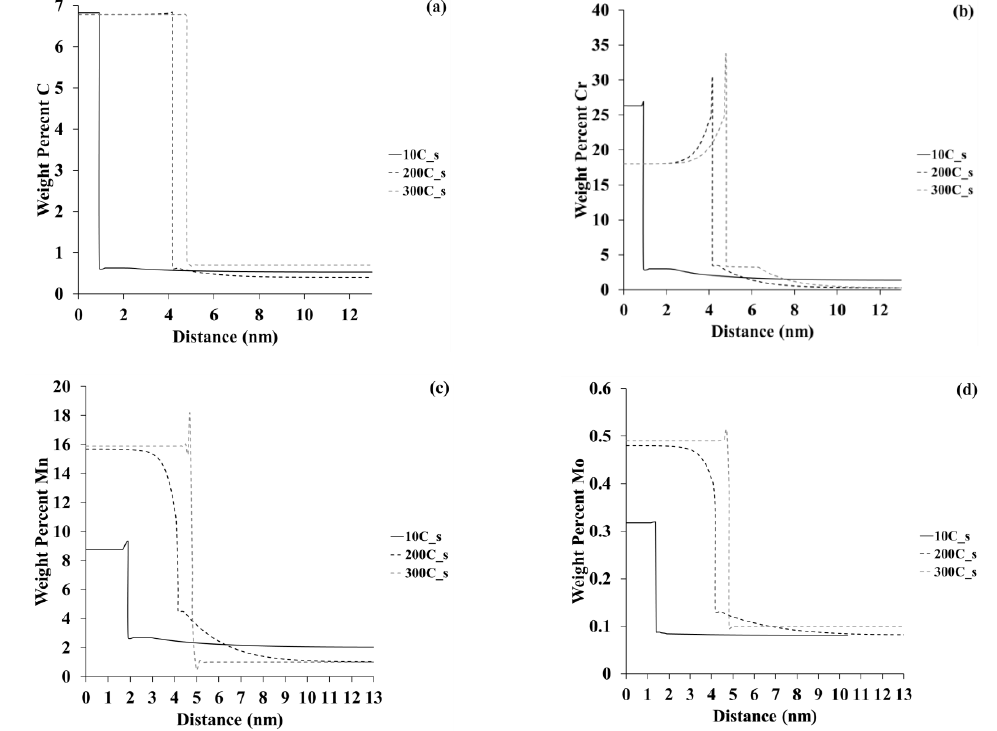
Figure 6. Diagrams of ( a ) carbon, ( b ) chromium, ( c ) manganese, ( d ) molybdenum concentration at the interface of cementite and austenite depending on heating rate at various temperatures within the α + γ region.